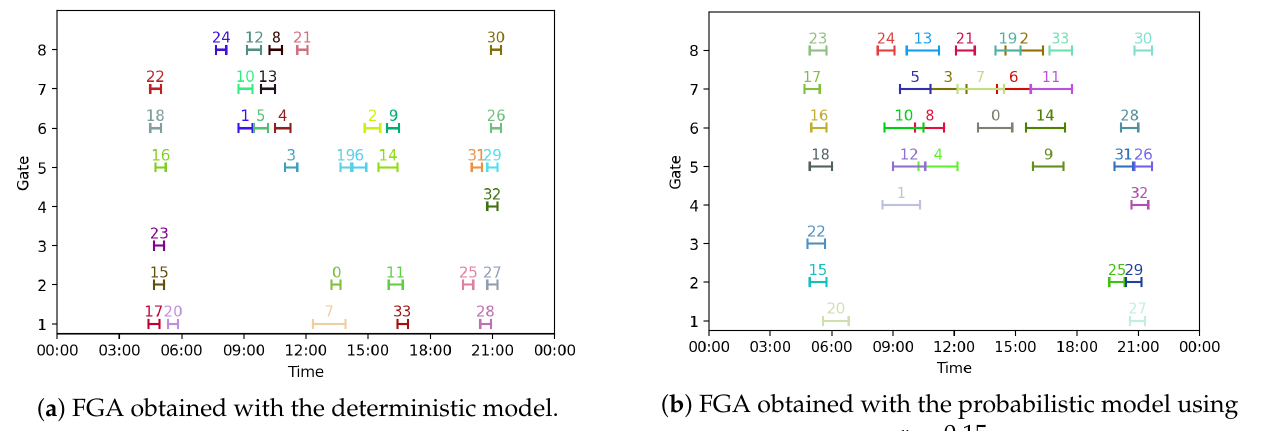
Figure 10. Flight-to-gate assignments for 14 July 2019 obtained using the deterministic and probabilistic models.